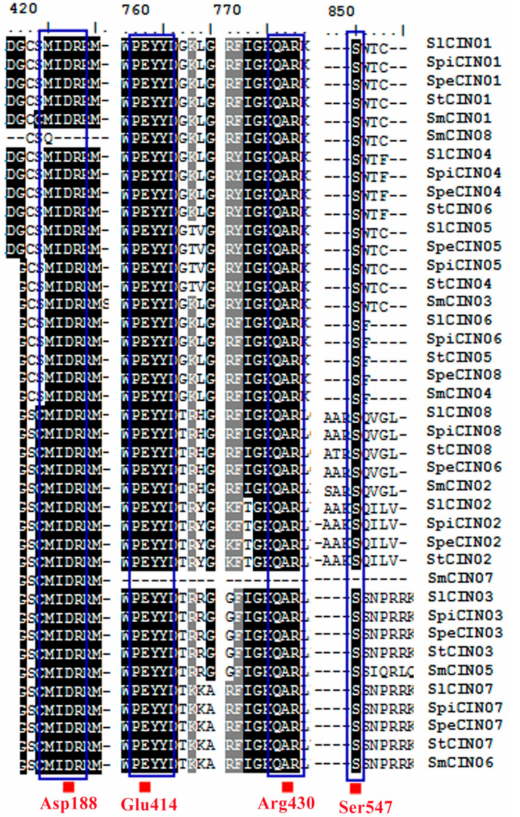
Figure 2. Conserved amino acid residues of CIN genes in Solanum . Species abbreviations: Sl: Solanum lycopersicum , Spi: Solanum pimpinellifolium , Spe: Solanum pennellii , St: Solanum tuberosum , Sm: Solanum melongena . Names of all CIN members listed on figure’s right side. Dark shading reflects 100% amino acid residue conservation. Four conserved catalytic residues (Asp188, Glu414, Arg430, Ser547) depicted by blue